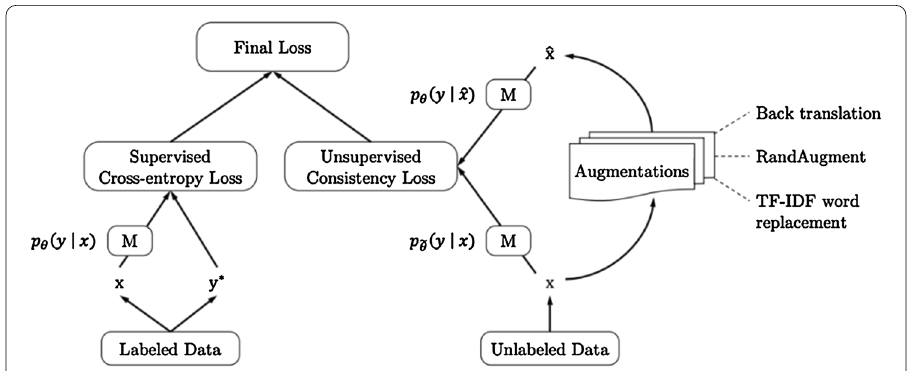
Fig. 6 Unsupervised data augmentation schema. Image taken from Xie et al.